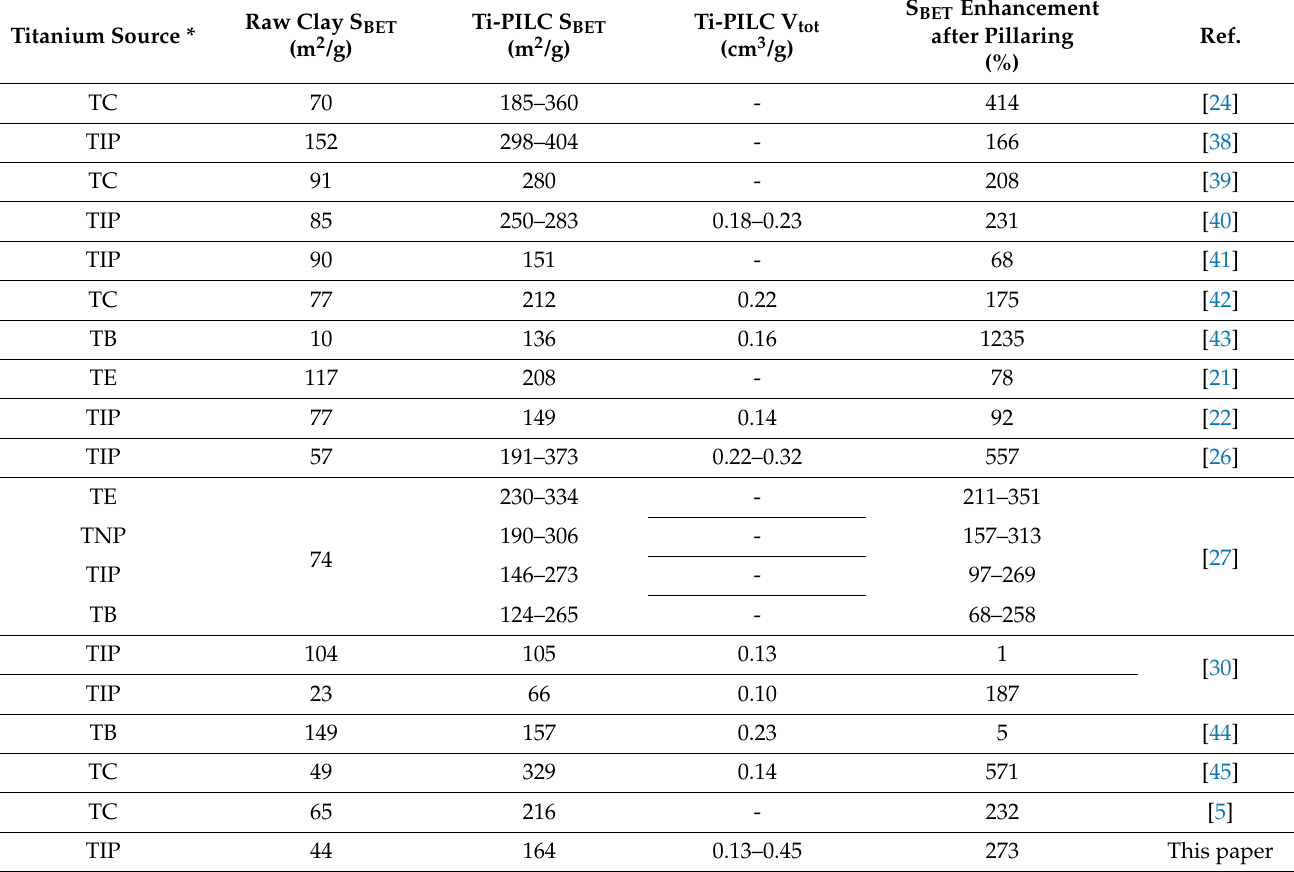
Table 1. Comparison of the highest specific surface area obtained in the present study with other Ti-PILCs from the